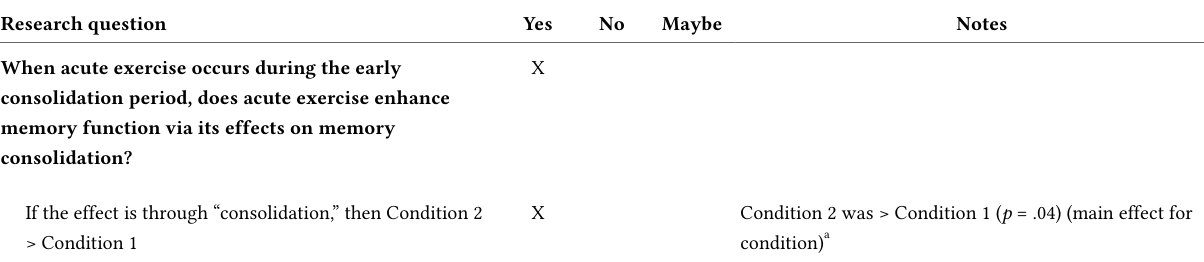
Summary of Results for Experiment